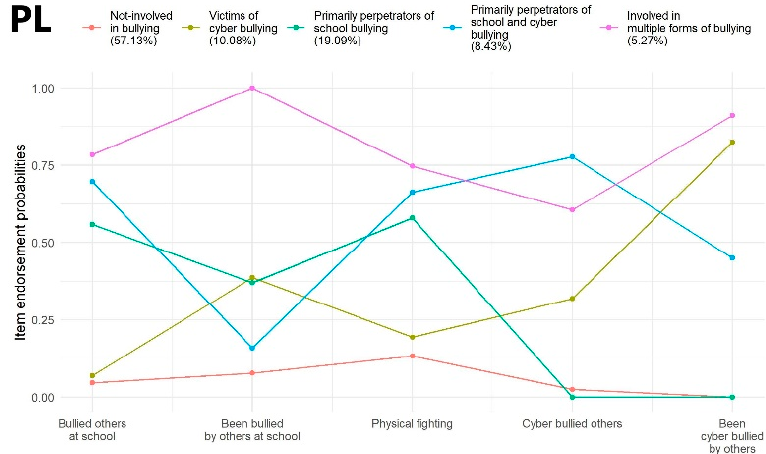
Figure 3 . Latent class profile of Poland.